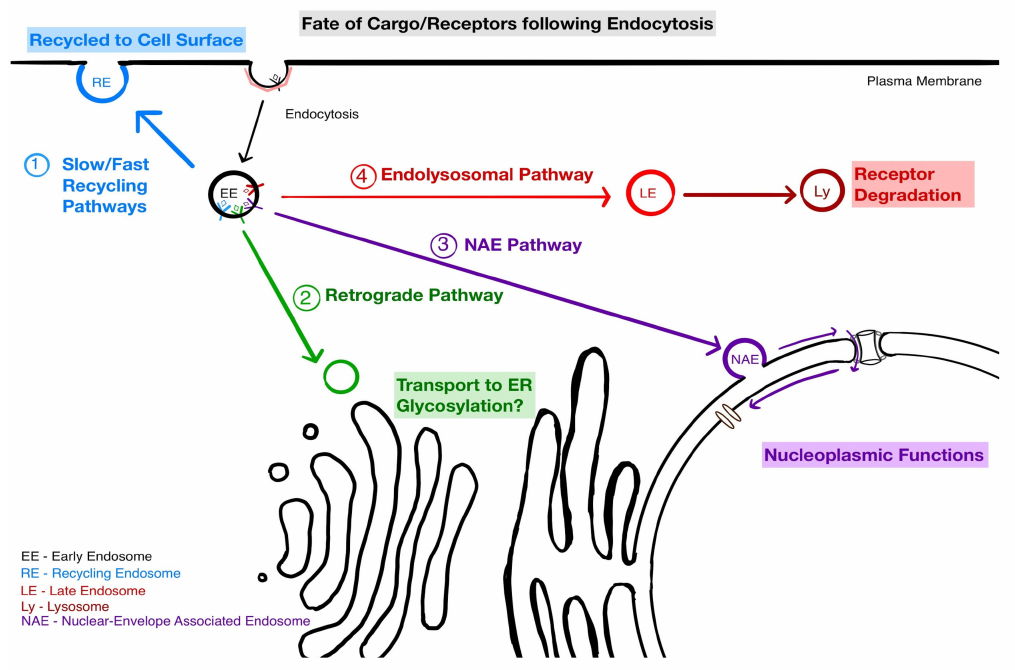
Figure 2. The pathways that internalised receptors can follow from the early endosomes (EE) and the fate of the receptors. (1) Recycling back to the cell surface via recycling endosomes (RE) (2); retrograde tra ffi cking to the Golgi Apparatus (GA); (3) transport to the nucleus in nucleus associated endosomes (NAE); (4) degradation after early endosomes maturation into late endosomes (LE) and fusion with